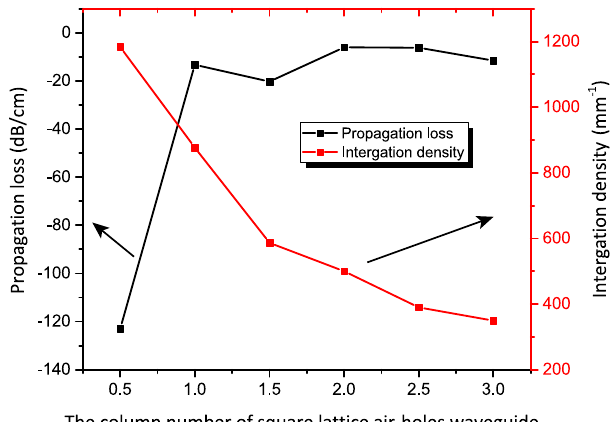
Figure 9. Propagation loss and integration density versus column number of air holes in the square-lattice hybrid waveguide at the wavelength of 1.55 µ m.